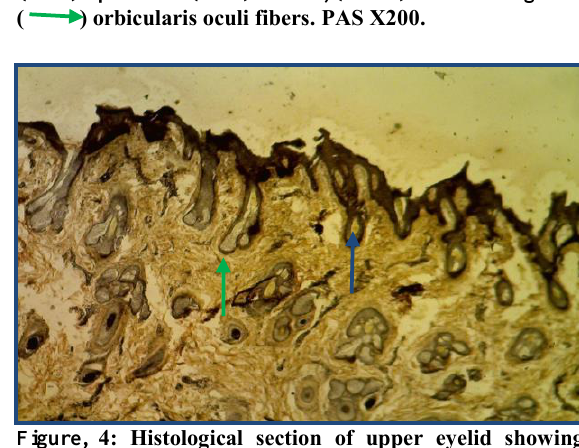
Figure, 4: Histological section of upper eyelid showing ( ) miebomian gland, ( ) lipid droplets in the miebomian gland. H and E.